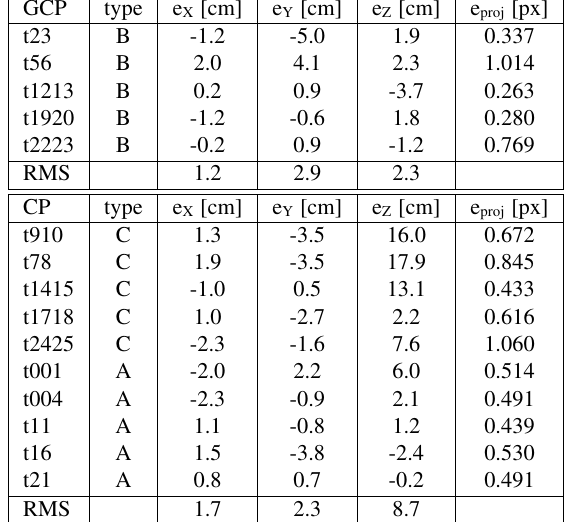
Table 4. Manhole covers as GCPs, errors on GCPs and